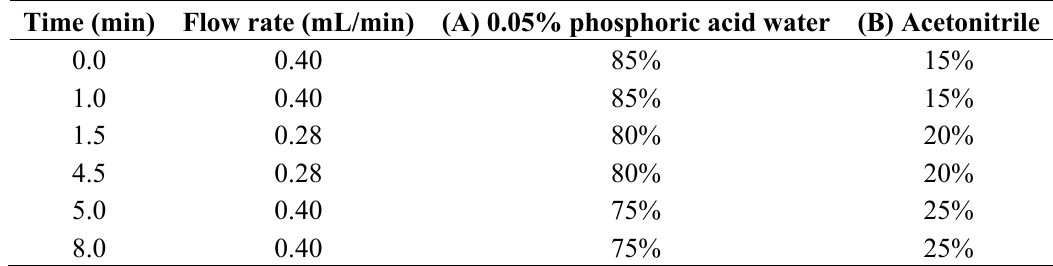
Table 1. UPLC gradient elution